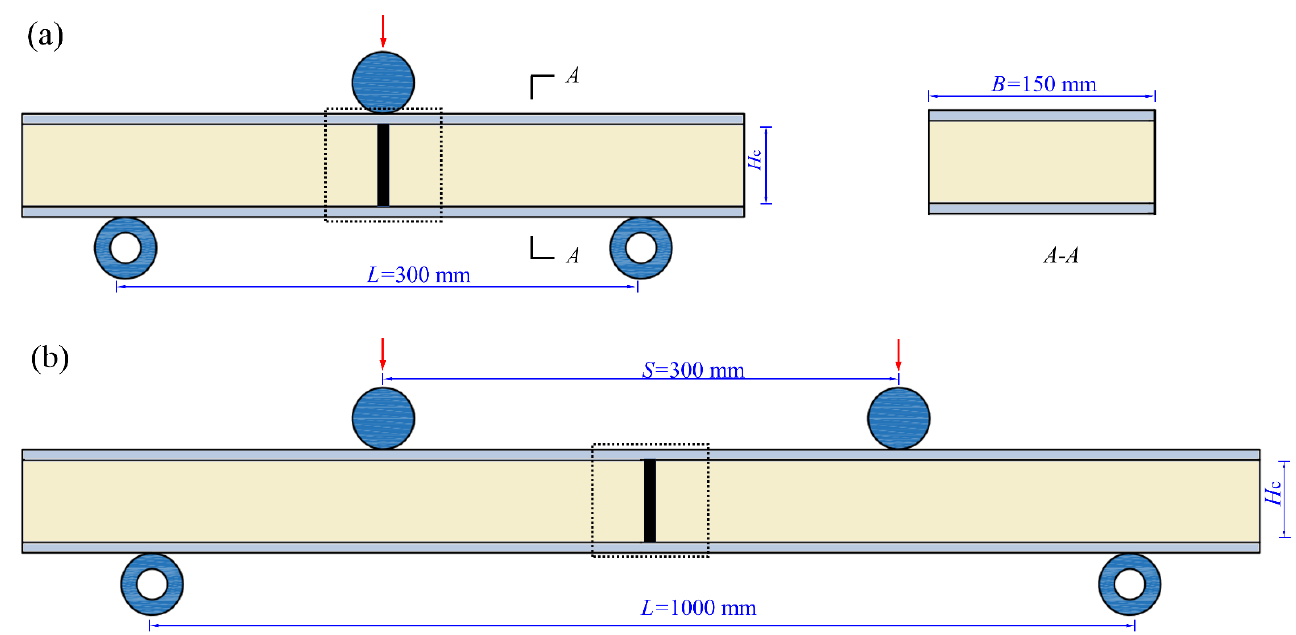
Figure 5. Schematic of panel-to-panel construction for three-point ( a ) and four-point ( b ) bending.